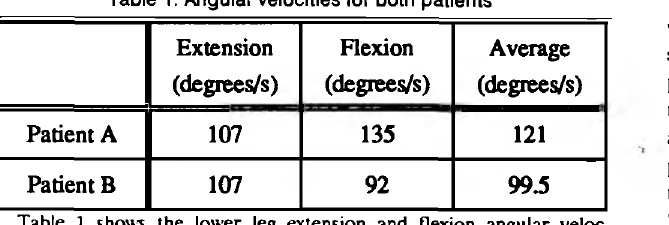
Table 1: Angular velocities for both patients